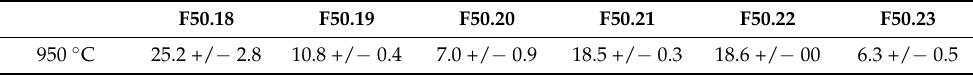
Table 15. The mean efficiency and SD of formulations F50.18–F50.23: EN60754-2 at 950 ◦ C.